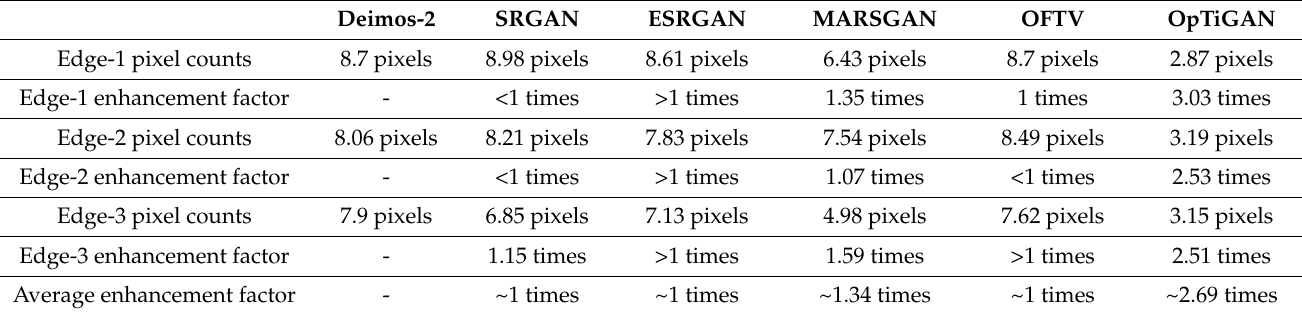
Table 6. Summary of slanted-edge measurement, as shown in Figure 9, for total pixel counts for the 20–80% rise of the edge profile and indicated effective resolution enhancement factor comparing to the input Deimos-2 image (upscaled by a factor of 4 for comparison).